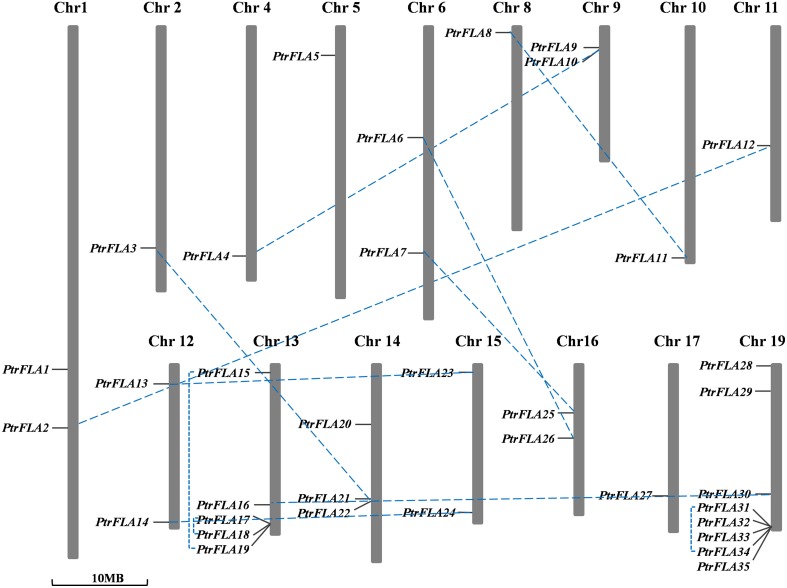
Chromosomal locations and duplicated gene pairs of PtrFLAs. The 35 PtrFLA genes were mapped to the 16 chromosomes. Three chromosomes (chr3, 7, and 18) have no PtrFLA gene. The chromosome number is indicated at the top. The duplicated gene pairs are connected with dotted blue line.